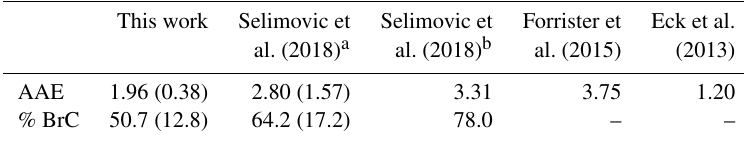
Table 3. Time-weighted study-average AAE and % BrC contribution compared to other studies. This work